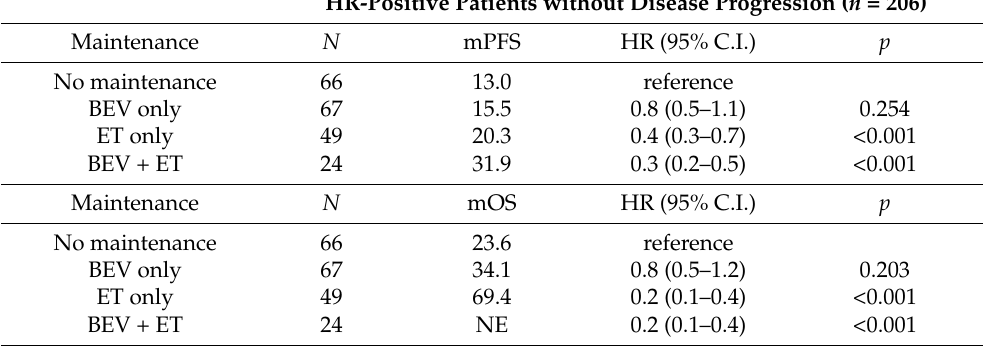
Table 4. Maintenance treatment after completion or discontinuation of bevacizumab-based treatment in HR-positive patients without disease progression. Survival times are measured in months.